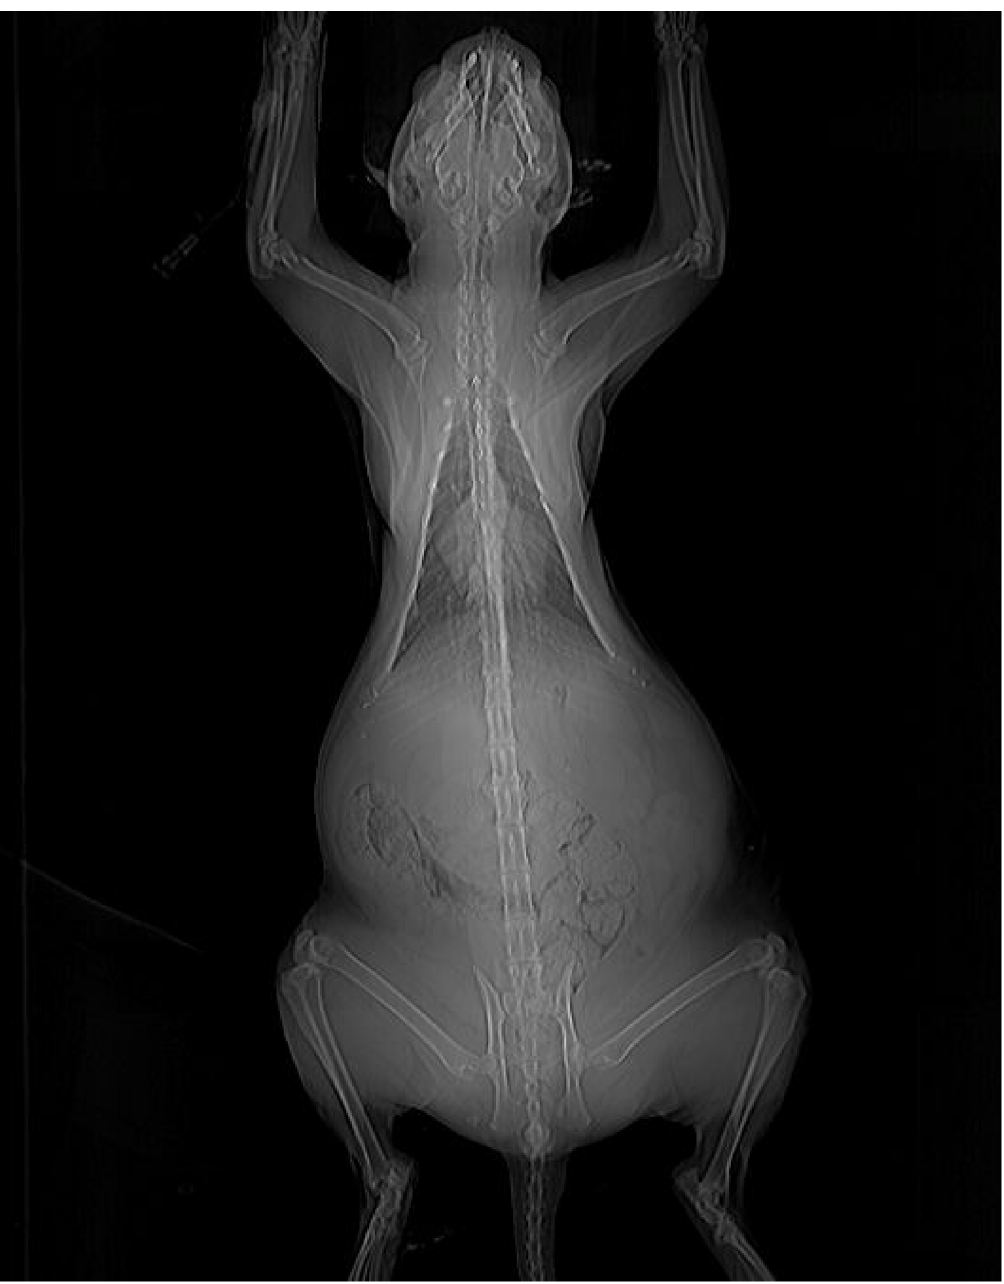
Fig 6. Radiograph of the chest and abdomen of an overtly acromegalic cat. Cranial abdominal organomegaly was demonstrated by this radiographic view of the chest and abdomen of a diabetic cat subsequently diagnosed with